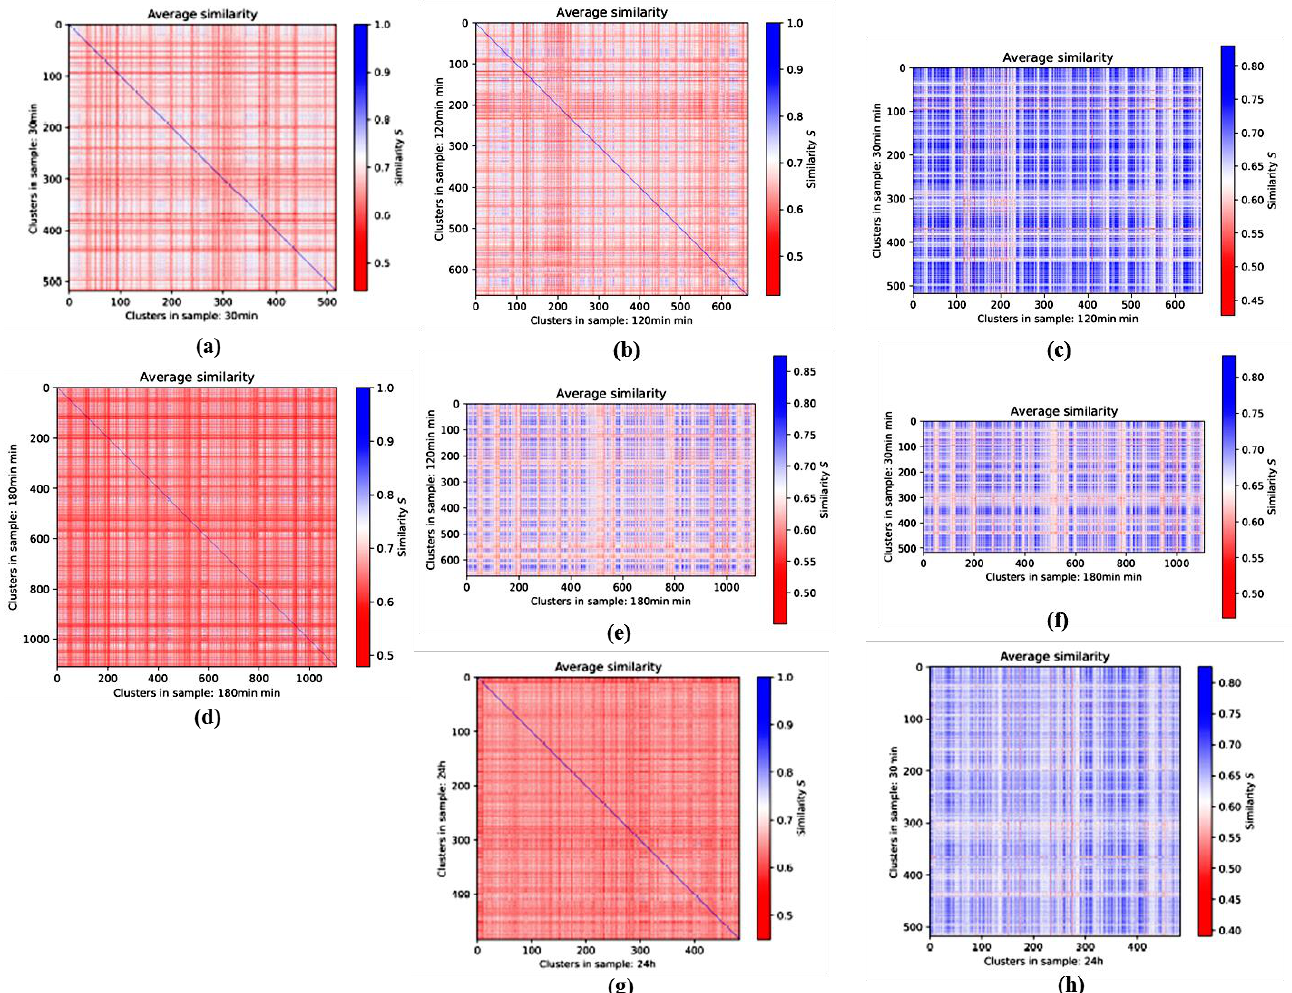
Figure 6. Averaged 1st-generation heatmaps of γ H2AX clusters of the skin fibroblast cell line CCD-1059SK. Pairwise comparison of clusters ( a ) 30 min, ( b ) 120 min, ( d ) 180 min, and ( g ) 24 h after irradiation. ( c ) Comparison of 30 min with 120 min clusters, ( e ) 120 min with 180 min clusters, ( f ) 30 min with 180 min clusters, and ( h ) 30 min with 24 h clusters. Note the differences in the color bars of the heatmaps comparing the same time point and comparing different time points.